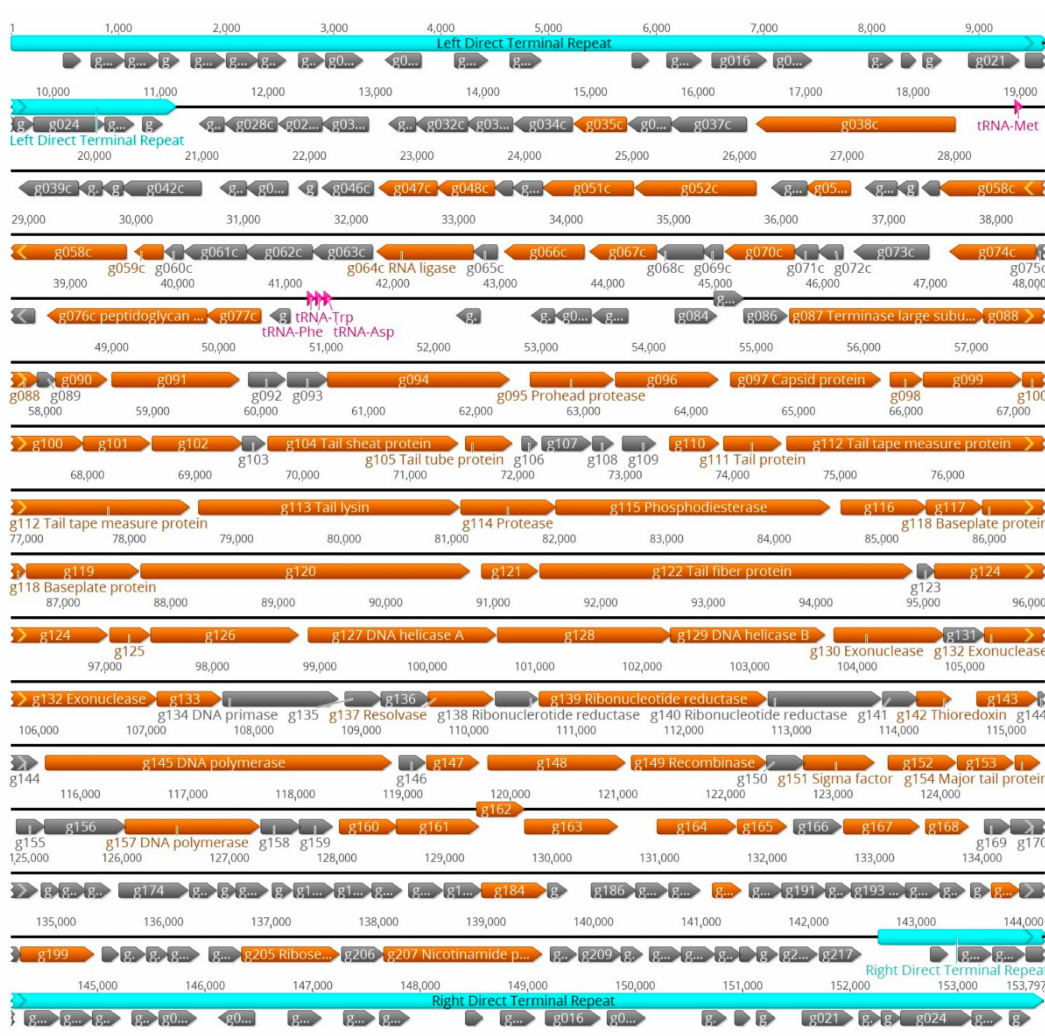
Figure 6. Genomic organization of phage Stab21 as a representative of the Stab phages. The sequence is shown as a black line on top of which are depicted the 11,149 bp long terminal repeat regions. The predicted genes are illustrated by arrows under the black line. The phage particle-associated gene products identified by LC-MS / MS are indicated by brown-colored arrows. The illustration was generated using Geneious 10.2 (https: //